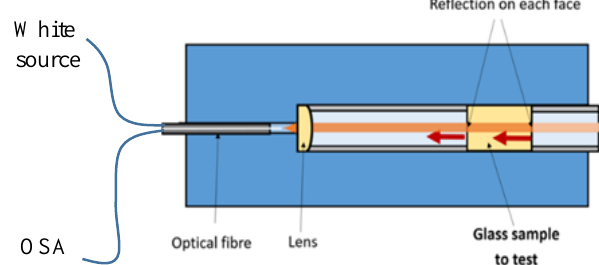
Figure 1 : Schematic diagram of the interferometric setup to measure refractive index or optical path change under radiative environment.